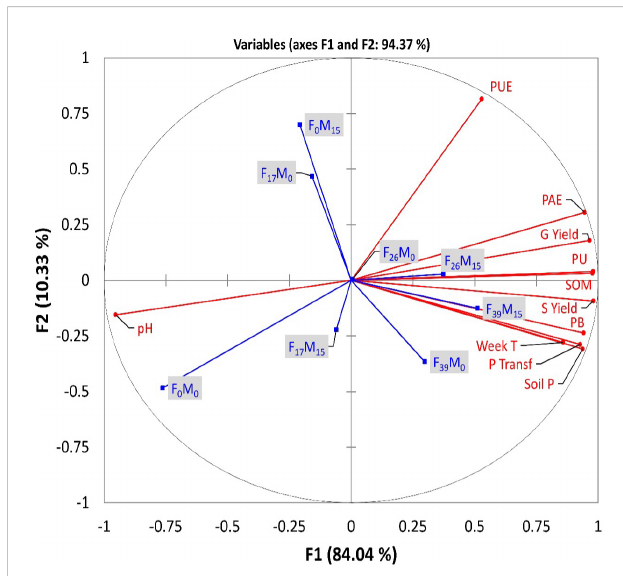
FIGURE 5 Principal component analysis (PCA) indicating the impact of treatments and their relationships with various soil properties and yield. Treatments (in blue font) are described in Table 1. Measured parameters (in red font) include phosphorus (P) use ef fi ciency (PUE), P acquisition ef fi ciency (PAE), grain yield (G yield), P uptake (PU), soil